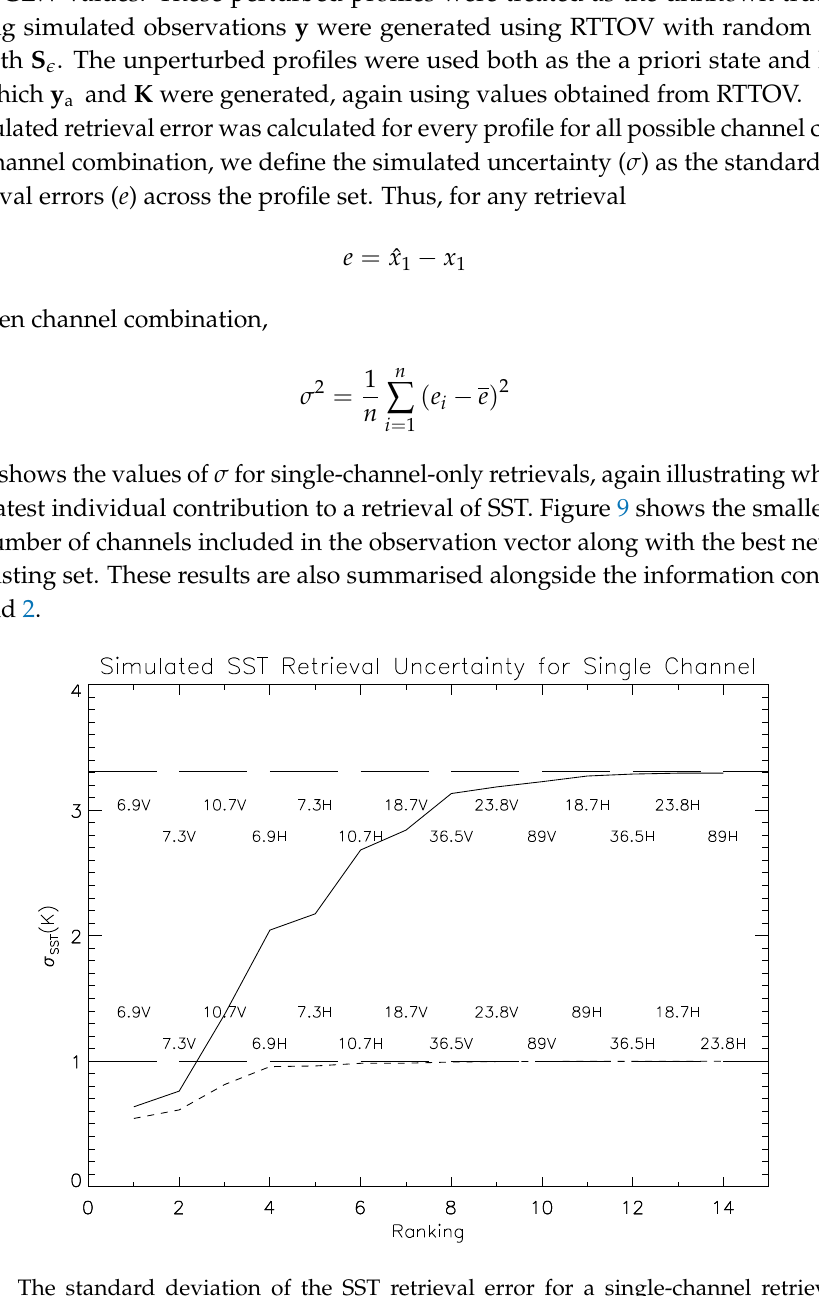
Figure 8. The standard deviation of the SST retrieval error for a single-channel retrieval from information content analysis. The upper set of channels and solid line come assume a four-variable retrieval vector and prior SST uncertainty of 3.31 K. The lower set and dashed line assume a five-variable retrieval vector, in which cloud liquid water is additionally accounted for, and priori SST uncertainty of 1.0 K. The prior uncertainty values in each case are shown in long-dashed lines.